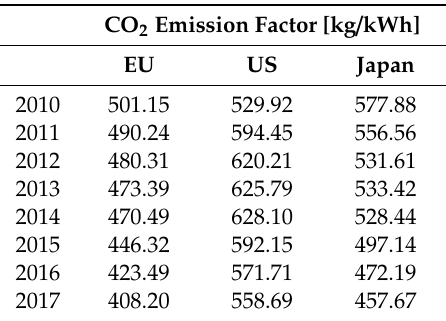
Figure 8. Avoided CO 2 emissions with forecast for the EU, US and Japan. Table 5. CO 2 emission factor.